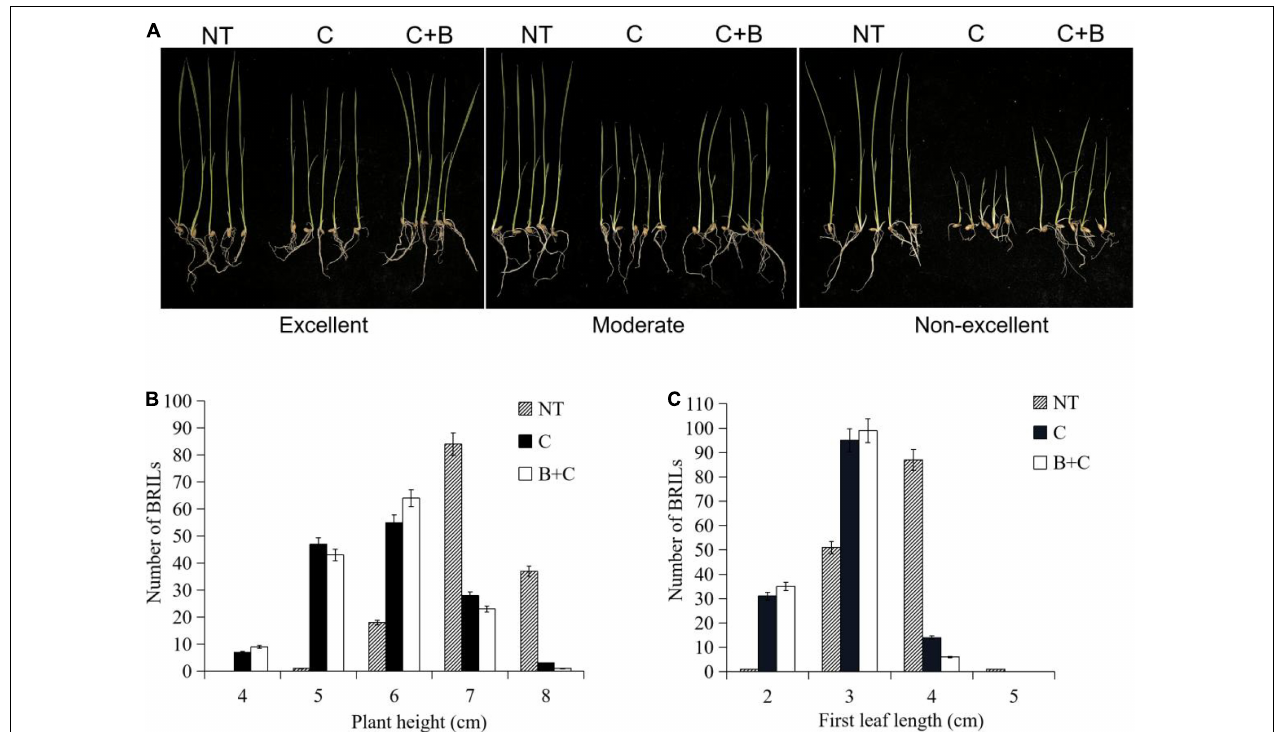
FIGURE 2 | Phenotypic characterization under cold stress and BR-combined cold treatment at the bud burst stage in BRILs. (A) Phenotypes of the representative BRILs with excellent, moderate, and non-excellent cold tolerance. (B) Ranges of the plant height in BRILs. (C) Ranges of the first leaf length in BRILs. NT, normal temperature; C, cold stress; C + B, BR-combined cold treatment.